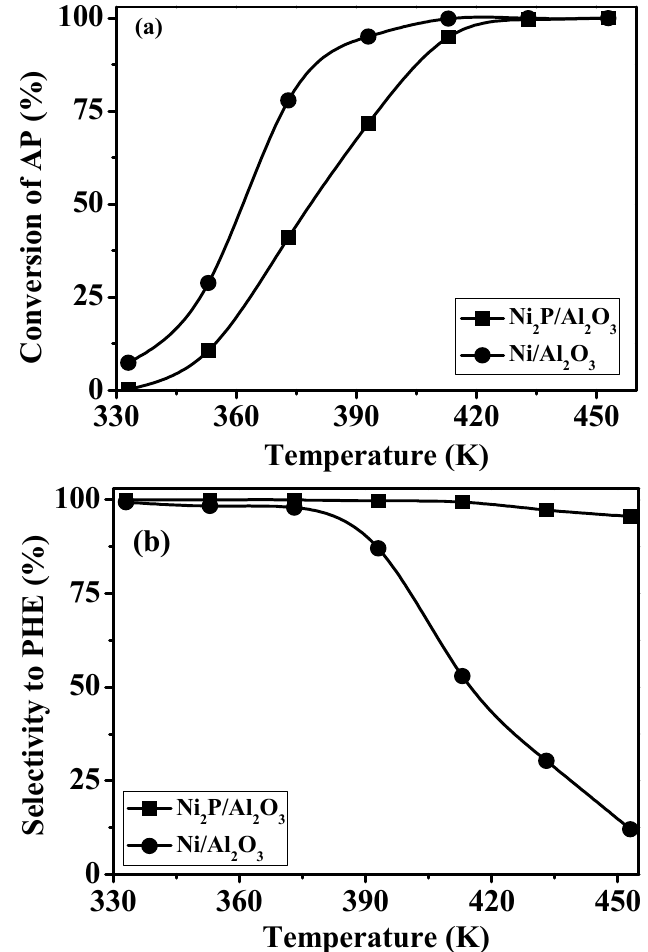
Figure 7. Conversions of AP ( a ) and selectivities to PHE ( b ) over the Ni/Al 2 O 3 and Ni 2 P/Al 2 O 3 catalyst. Reaction conditions: p = 3.0 MPa, H 2 /AP = 5, WHSV =